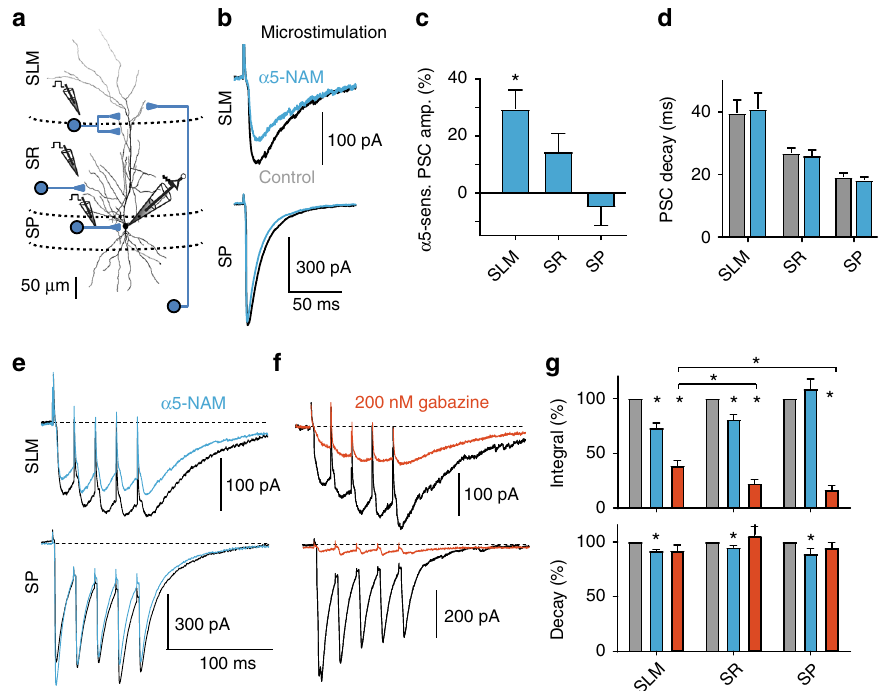
Fig. 1 GABAergic synapses onto pyramidal-cell dendrites activate α 5-GABA A Rs. a Experimental design. Targeted projections from local interneurons are indicated. b IPSCs evoked by electrical stimulation in different layers (SLM stratum lacunosum moleculare, SR stratum radiatum, SP stratum pyramidale) were recorded at – 70 mV in the presence of 10 µ M NBQX and 25 µ M AP5 using a CsCl-based pipette solution. Representative mean IPSCs before (black) and after addition of the α 5-NAM RO4938581 (1 µ M, blue) show that only IPSCs evoked in the dendritic layers were sensitive to the α 5-NAM. c Group means of the normalized α 5-NAM-sensitive component in SLM-evoked IPSCs ( P < 0.01; one sample t test, n = 6) and SR-evoked IPSCs ( P = 0.085; Wilcoxon signed rank test, n = 11). d The mean decay time constant of single IPSCs evoked in different layers of CA1 was not affected by the application of the α 5-NAM. e Brief-burst stimulation (5@50 Hz) of putative dendritic (SLM) and perisomatic (SP) IPSCs before and after (blue) application of the α 5- NAM (1 µ M, blue). f Effect of 200 nM gabazine on burst IPSCs. g Top, bar graph showing that application of the α 5-NAM reduced the IPSC burst integral